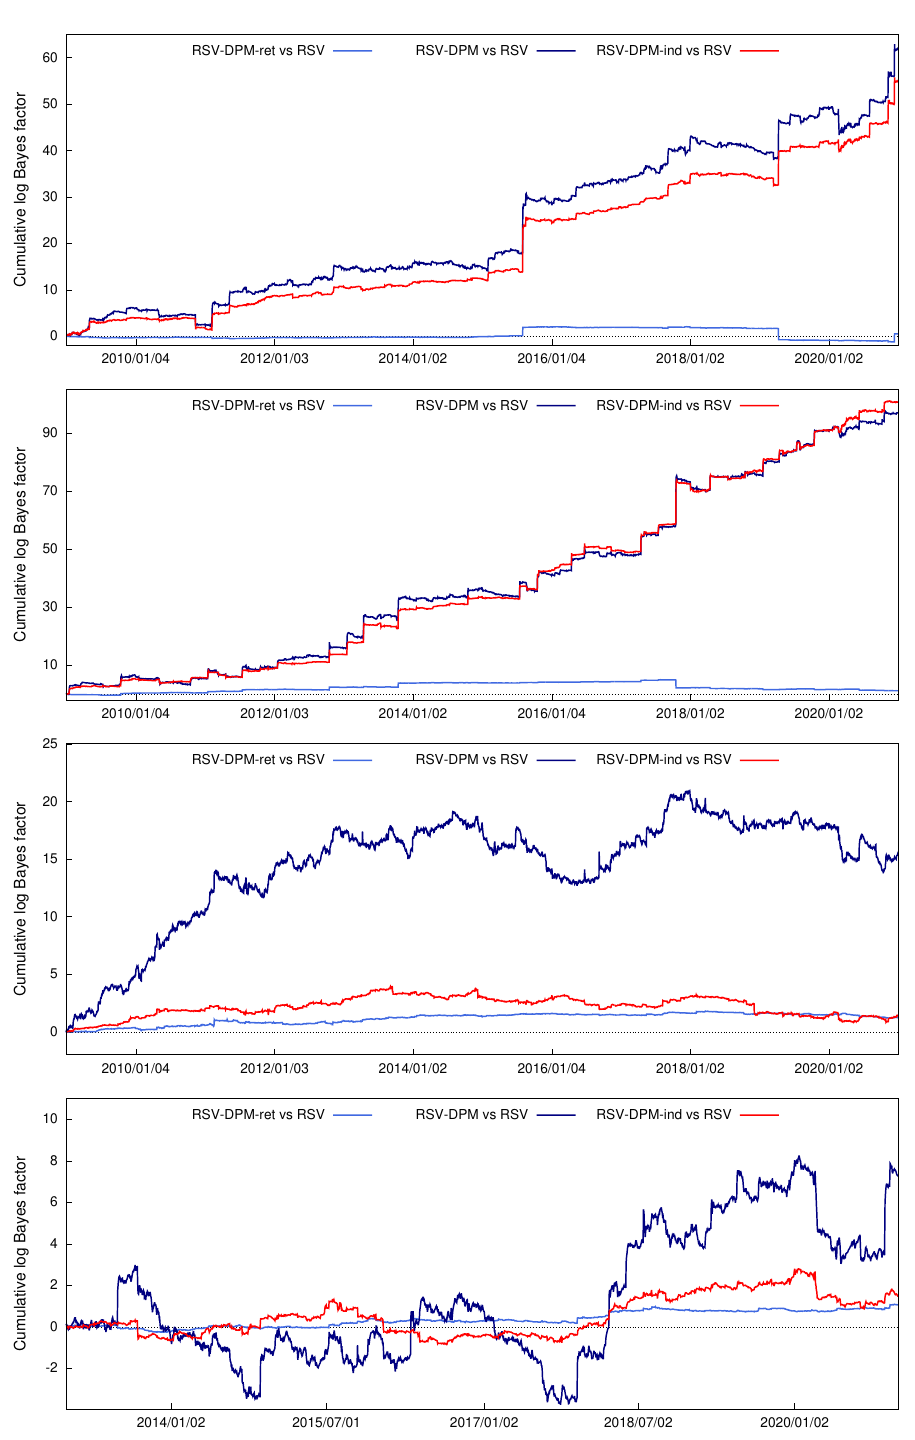
Figure 7. Cumulative log predictive Bayes factors for semiparametric RSV models vs the RSV model (from top to bottom: DIS, IBM, SPY and